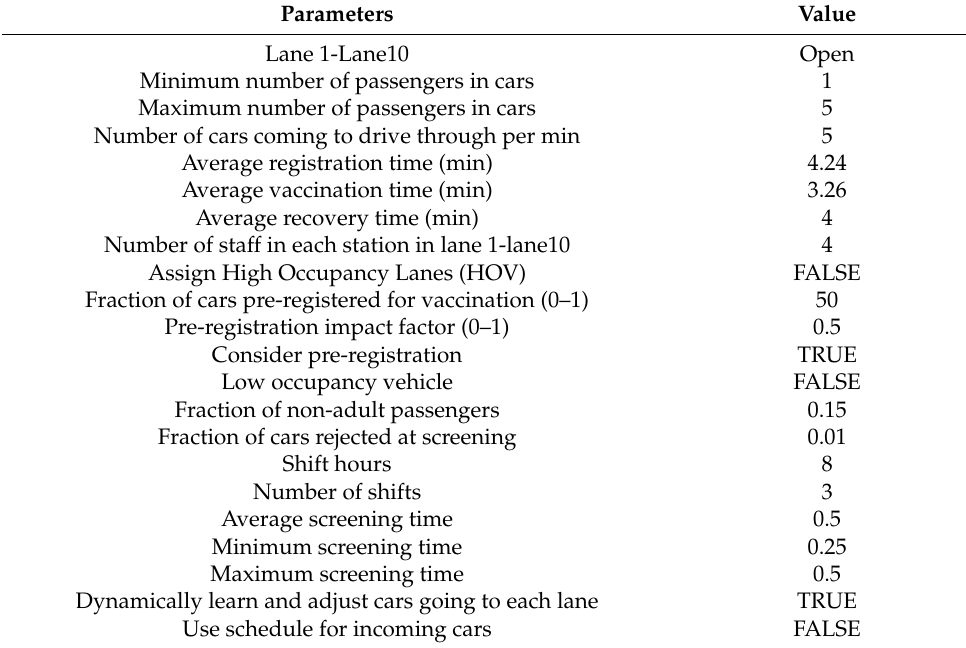
Table 1. Parameter settings for the sample drive ‐ through simulation experiment.